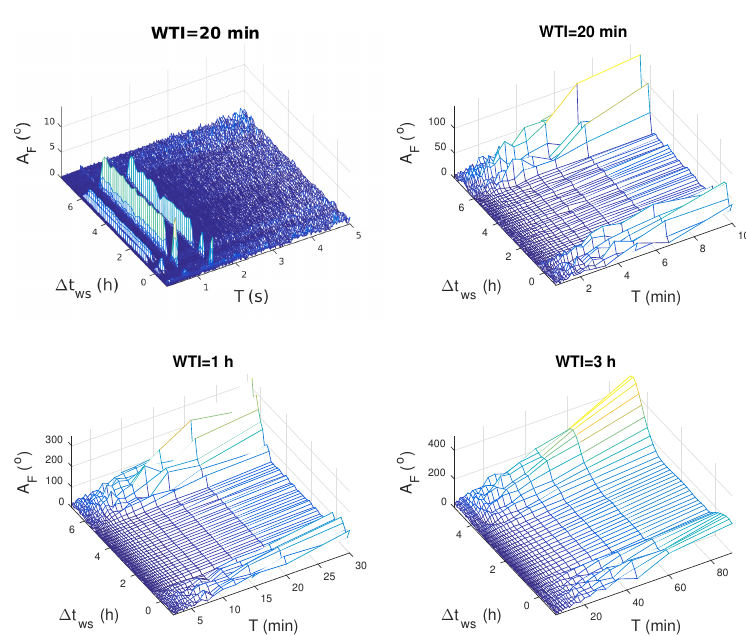
Figure 7. Fourier amplitude of waves with period T obtained by applying FFT to the ICV signal phase recorded in time around EQ occurred near Kraljevo on 4 November 2010 with window time intervals (WTI) of 20 min (upper panels), 1 h (bottom left panel), and 3 h (bottom right panel) which begin with a ∆ t WS shift with respect to the EQ time.